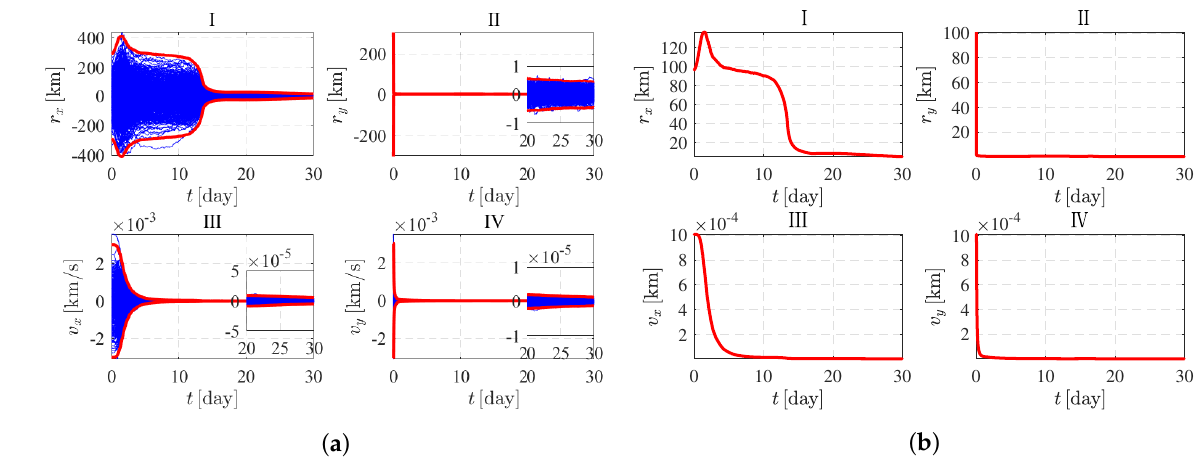
Figure 10. Results of the Monte Carlo simulation of the 1th orbital period. ( a ) 500 times shooting results. ( b ) 3-sigma curve.